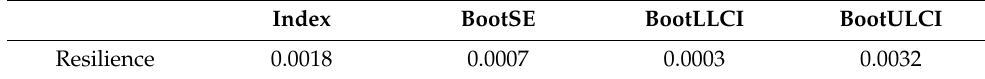
Table 8. Index of moderated